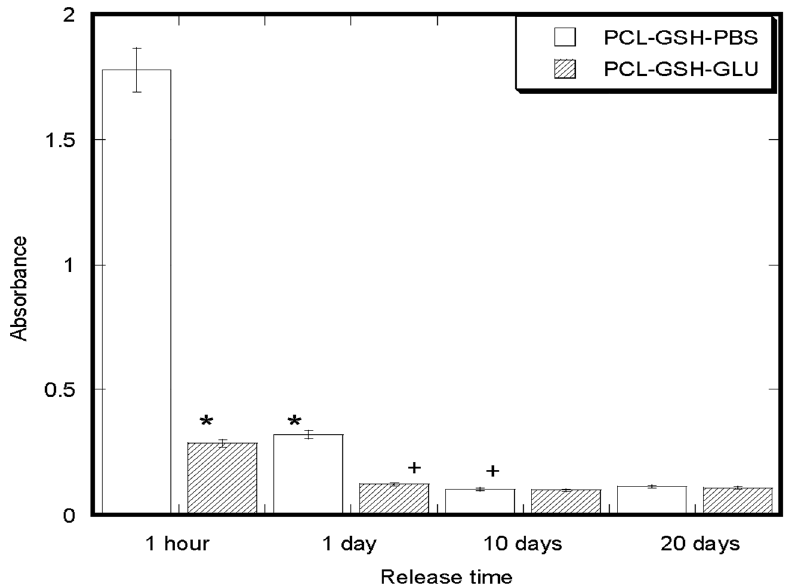
Figure 6. Glutathione release from PCL nanofibers during tested periods. In the figure, * refers p < 0.05 compared to PCL-GSH-PBS absorbance value after 1 h and * refers p < 0.05 compared to PCL-GSH-PBS absorbance value after 1 day. + refers p < 0.05 compared to PCL-GSH-PBS absorbance value after 10 days.